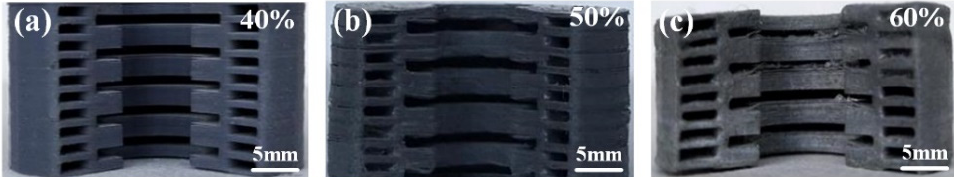
Figure 3. Cross-section of shaped grain samples with different solid contents: ( a ) 3D printed sample with solid content of 40%; ( b ) 3D printed sample with solid content of 50%; ( c ) 3D printed sample with solid content of 60%)